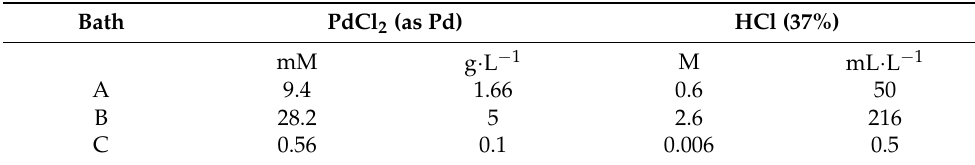
Table 1. Palladium displacement plating baths nomenclature and their relative composition.